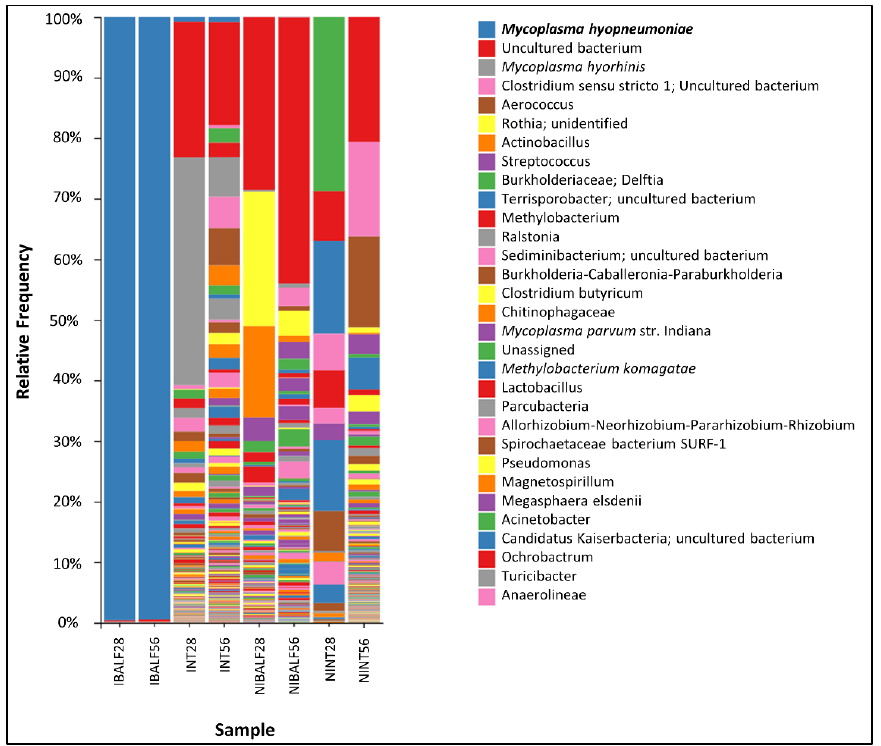
Figure 3. Taxonomic analysis with relative frequencies of each bacterial genera from pooled nasal turbinate and BALF samples of infected and control animals at 28 and 56 dpi.